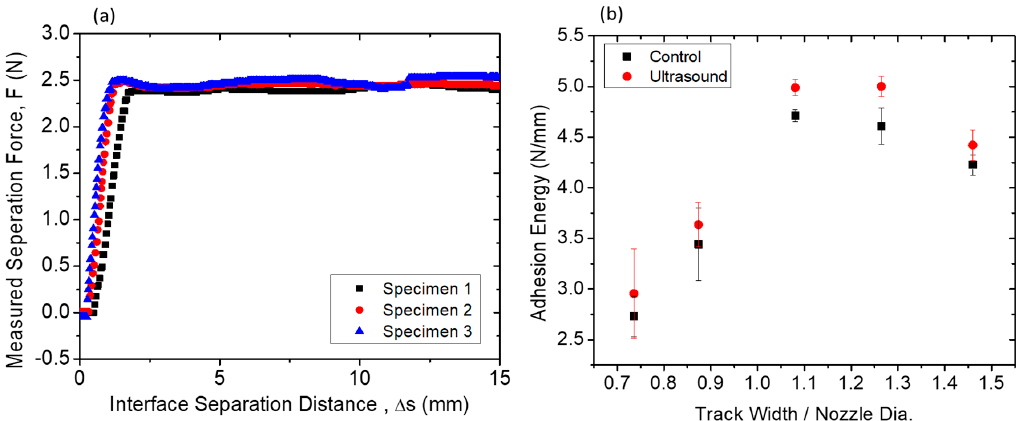
Figure 4. ( a ) Force-Separation distance curves for 1.0 mm-wide example peel tests ( b ) Interfacial adhesion strength dependence on width of printed tracks for control and ultrasonic vibration-assisted FFF conditions. The error bar represents the standard deviation of adhesion strength measured for four test specimens at a given track width, both in control and ultrasound condition.